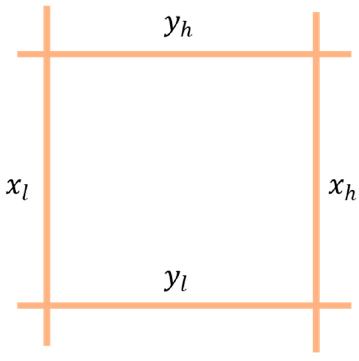
Figure 8. Square defined as the intersection of four straight lines.